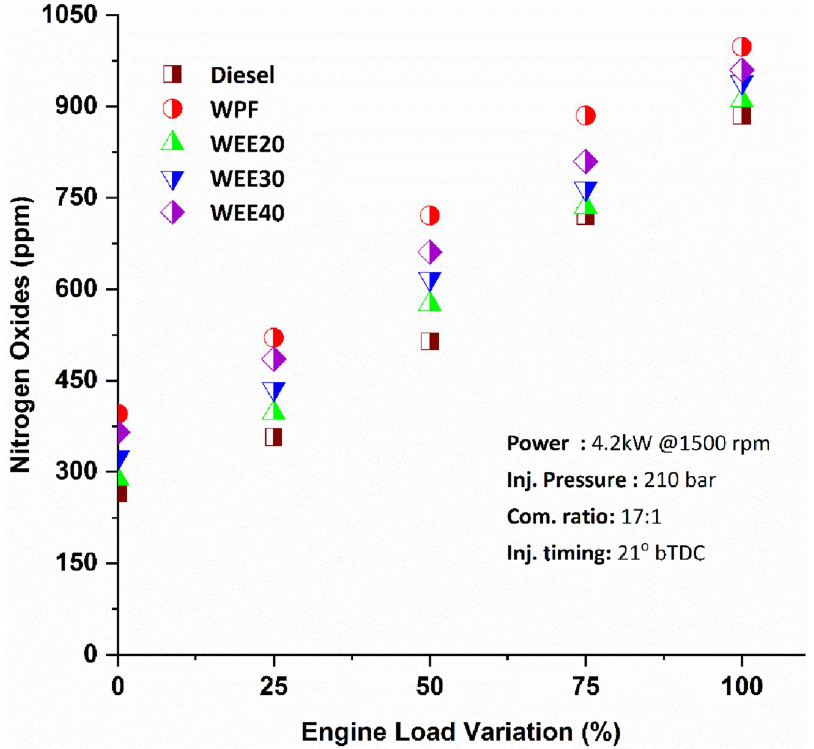
Figure 7. Variation of nitrogen oxide emissions on engine